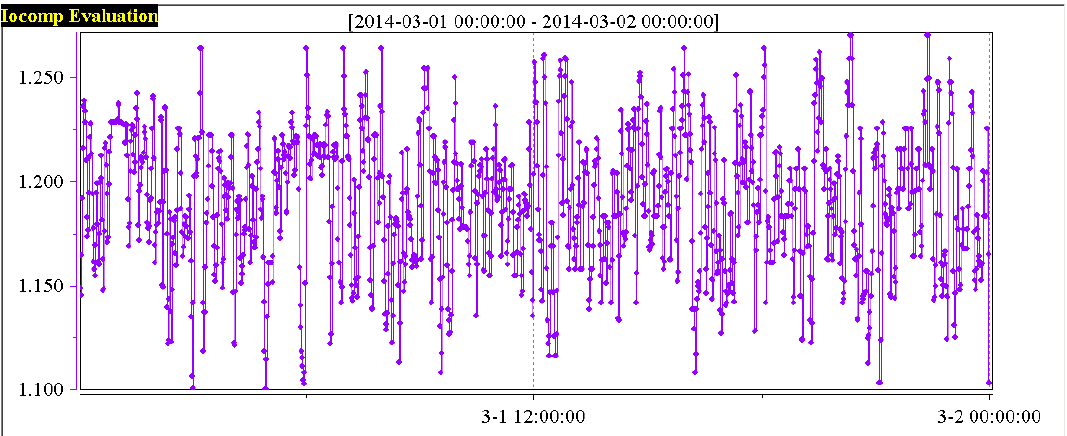
Figure 17. The boiler oxygen content